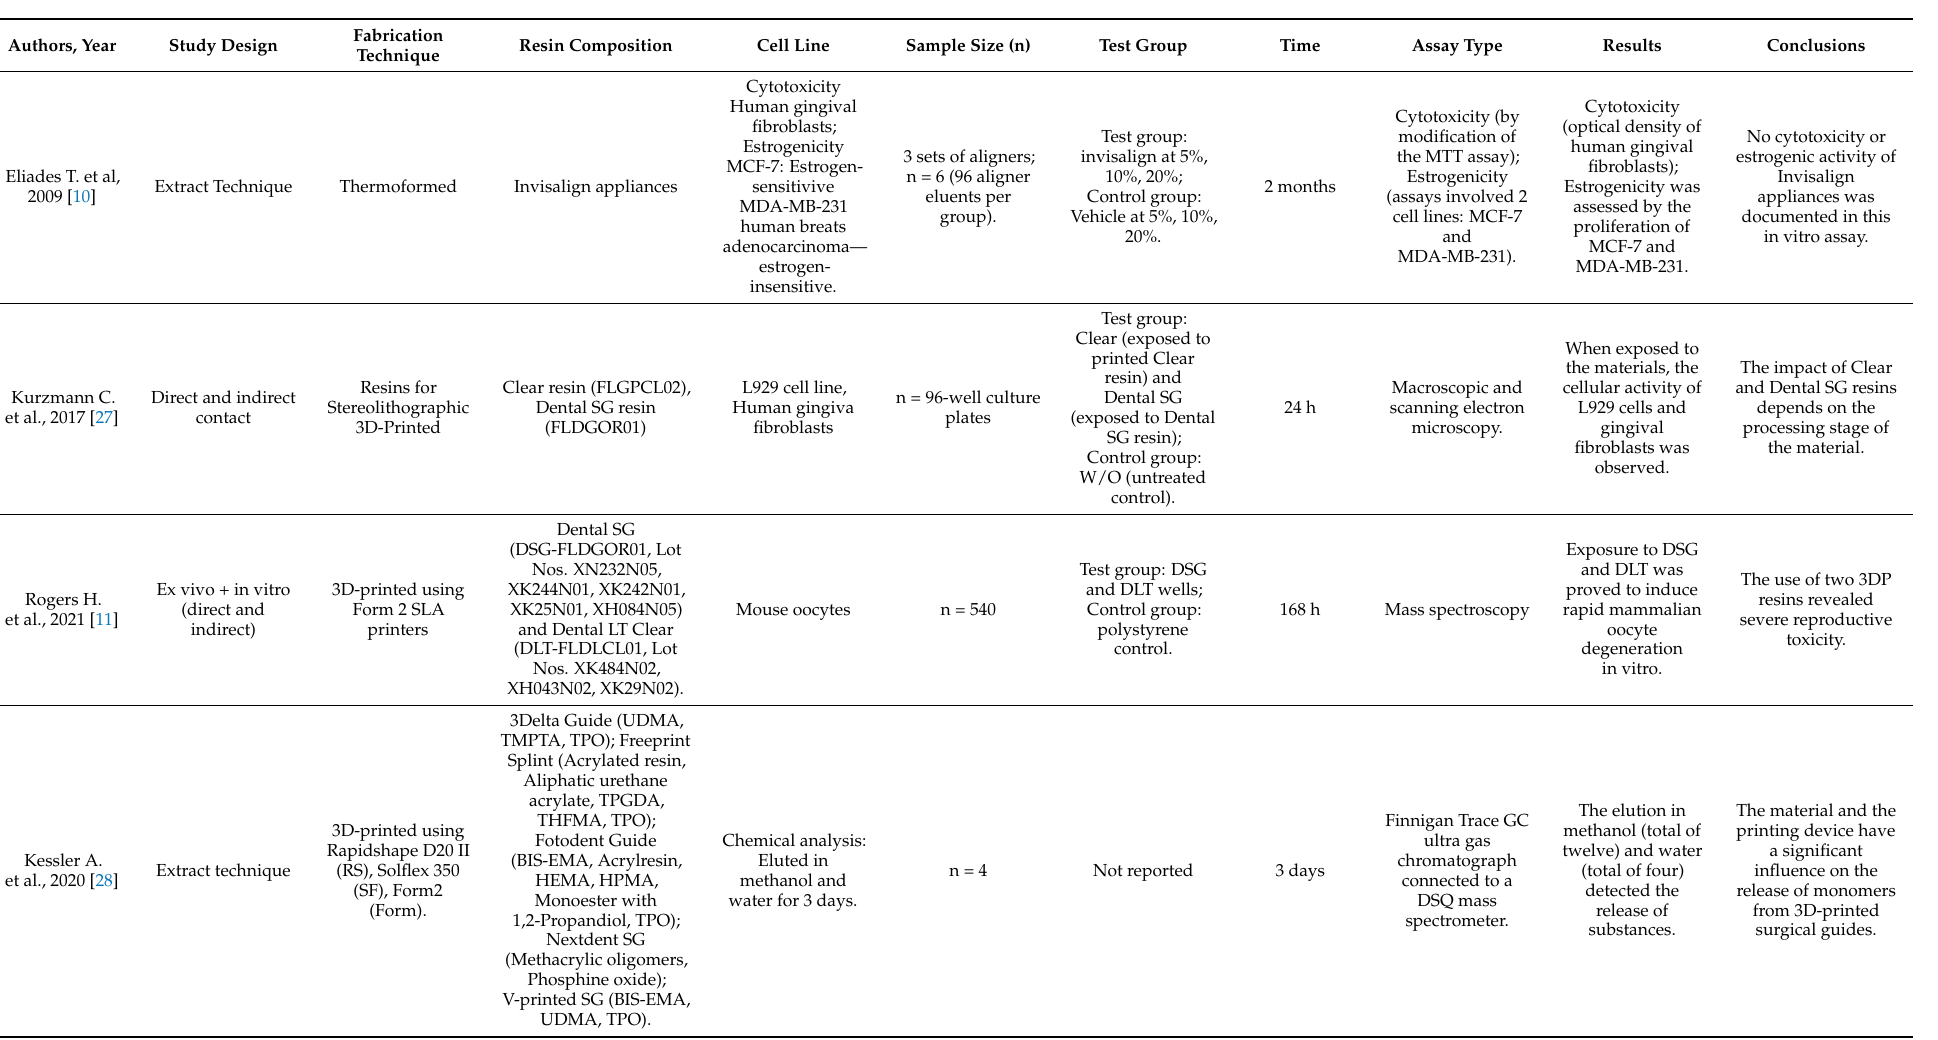
Table 1. Summary of parameters and results from in vitro included